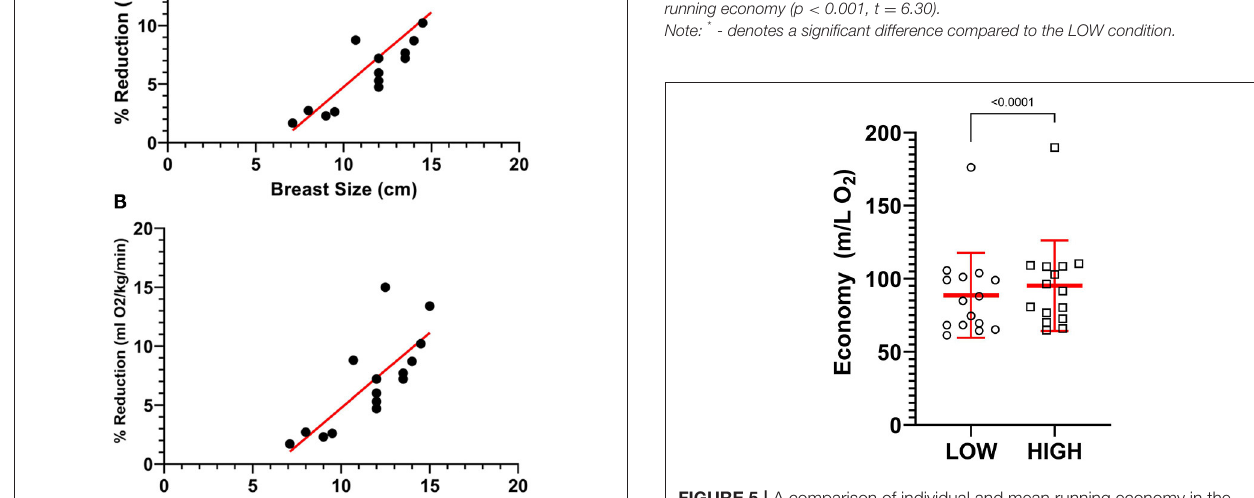
FIGURE 5 | A comparison of individual and mean running economy in the LOW and HIGH support conditions during the treadmill running task. A significant increase in running economy was observed in the HIGH compared to LOW support conditions. time, and step length. No differences were observed in